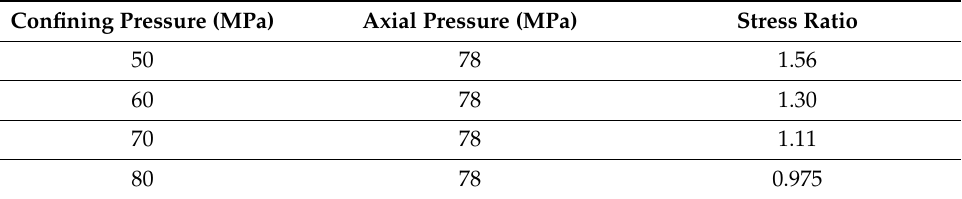
Table 4. The experimental scheme for sample No. 3-2-14-1.